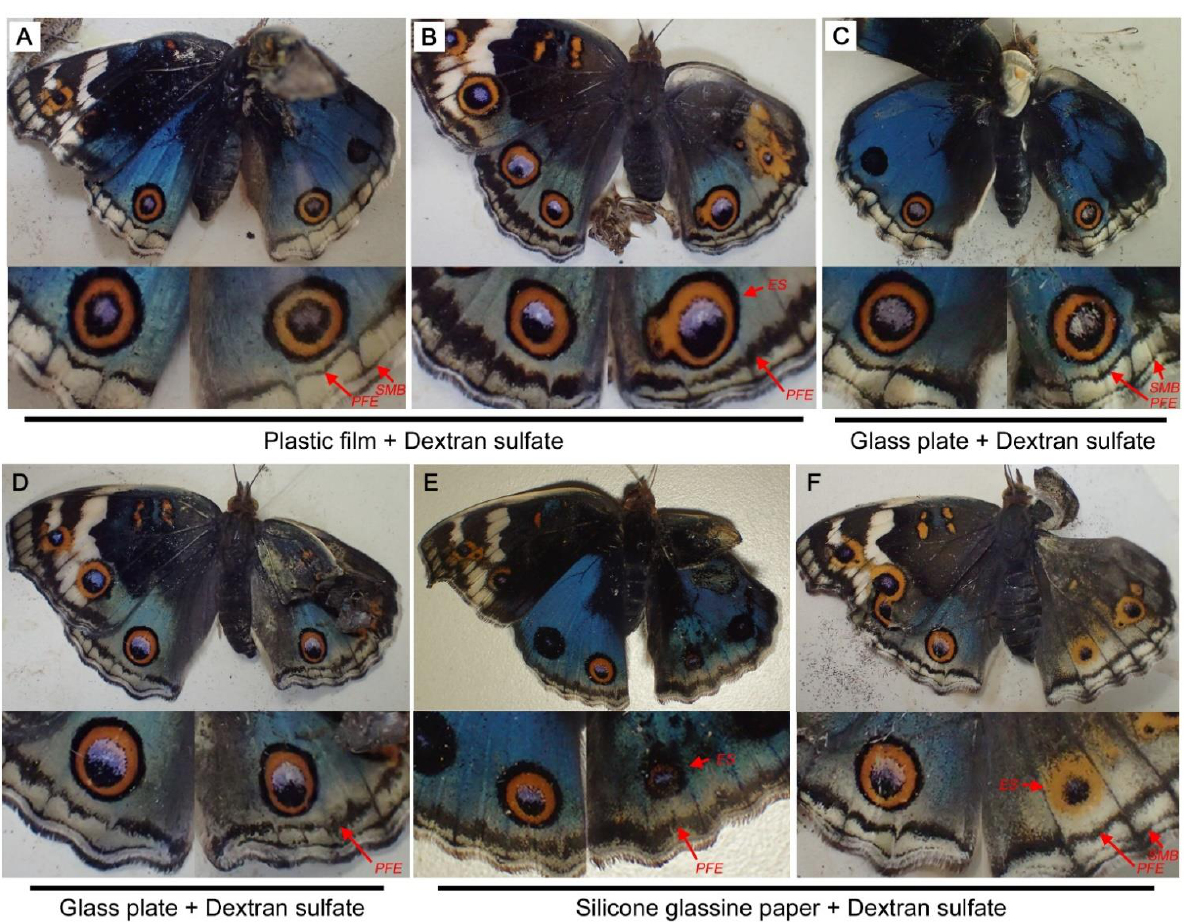
Figure 10. Double treatments with a covering material and dextran sulfate. Only the right dorsal hindwing was treated with a covering material. The top panels show the dorsal view of treated individuals, and the bottom panels show magnification of the posterior eyespots on the dorsal hindwings. Eyespot (ES), parafocal element (PFE), and submarginal band (SMB) are indicated by red arrows. ( A , B ) Individuals treated with plastic film and dextran sulfate. ( C , D ) Individuals treated with glass plate and dextran sulfate. ( E , F ) Individuals treated with silicone glassine paper and dextran sulfate.